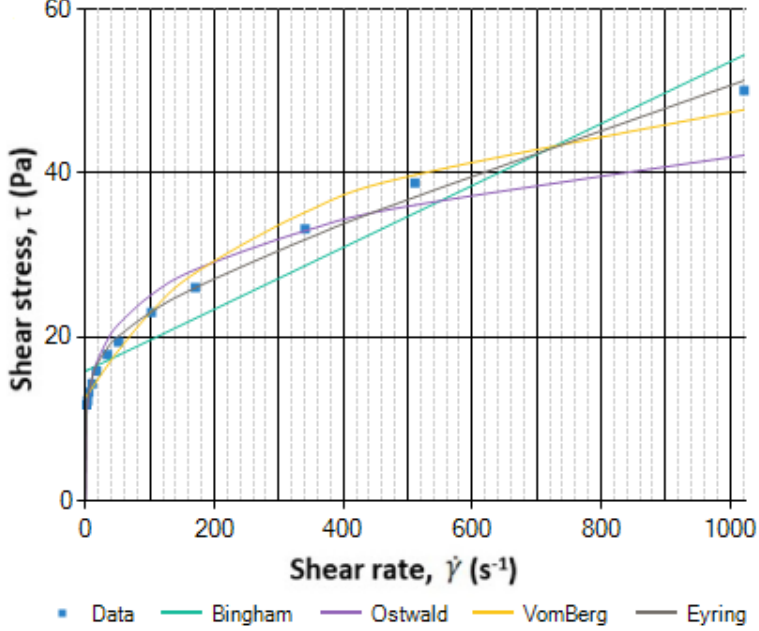
Figure 10. Comparison of the selected rheological models, 3% drilling mud with an addition of 2% XCD.